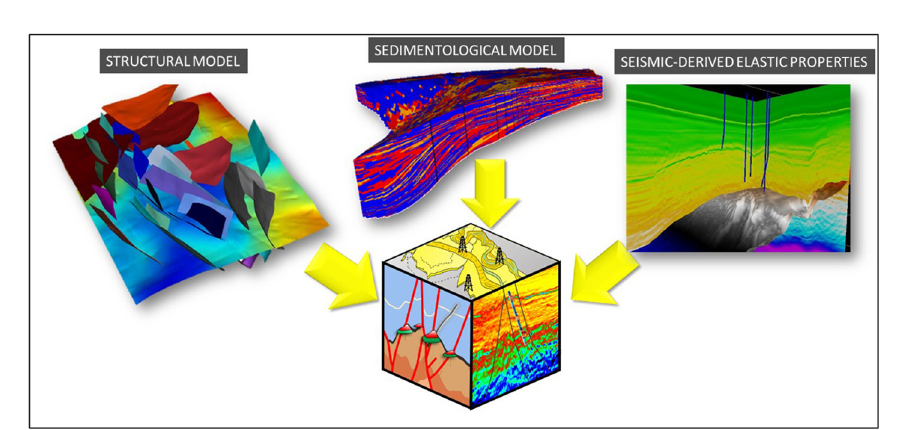
Fig. 23. – A “shared model” approach to integrated G&G studies. All results from each disci- pline are combined into a single 3D geological model, that can be used as input for all further